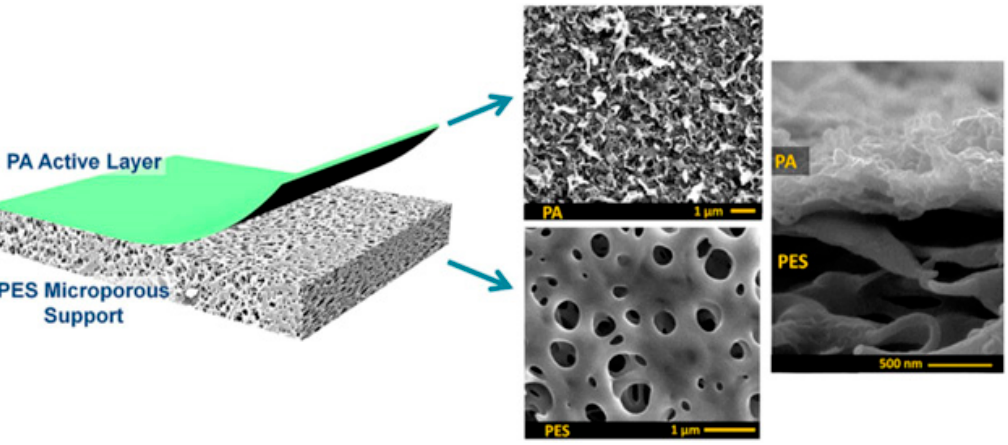
Figure 1. Polyamide thin film composite membrane, reproduced with permission from Khorshidi et al.